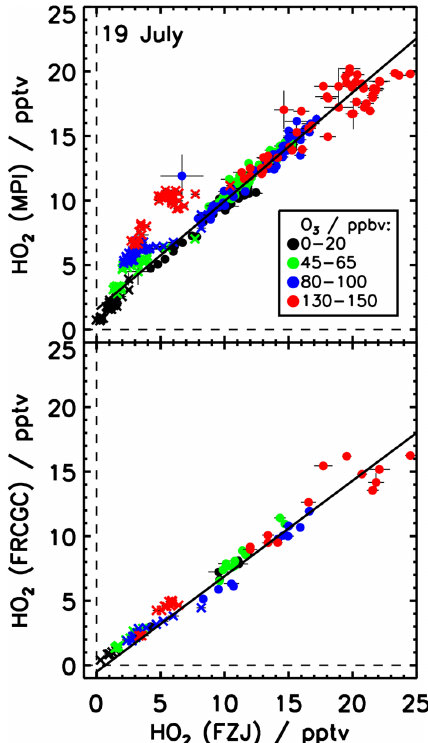
Fig. 10. Correlation of HO 2 mixing ratios on 19 July, when the ozone mixing ratio was varied. The water mixing ratio was 1.0– 1.4%. Solid line shows the result of the linear fit. Data taken when the chamber roof was closed (crosses in Figure) were excluded from the